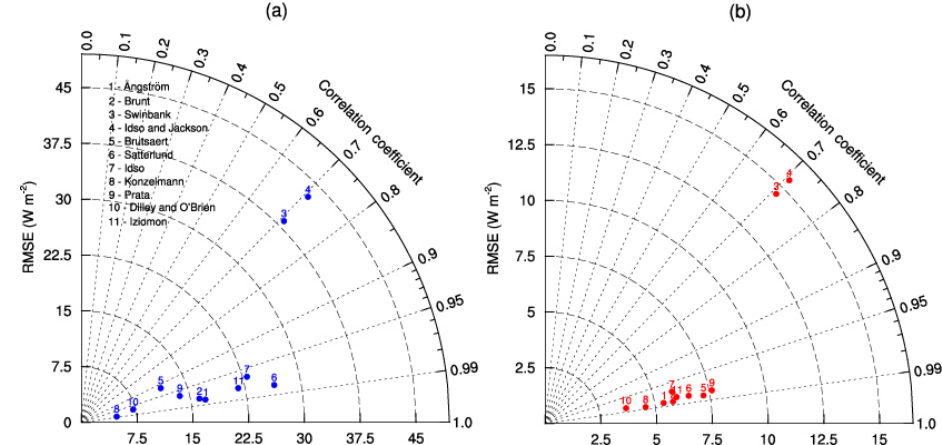
Figure 2. RMSE and R 2 for the clear-sky DLR parametrizations using original (a) and locally calibrated (b) coefficients. Table 3. Locally fitted clear-sky DLR parametrizations over the